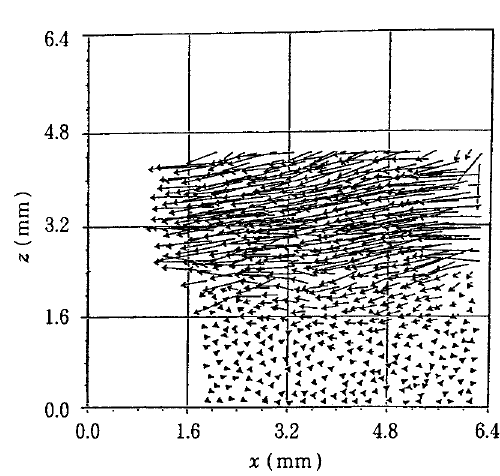
Fig. 11 . Particle velocity vector diagrams ( σ zz = 990Pa, Y = 2.3 〜 2.5mm, t =